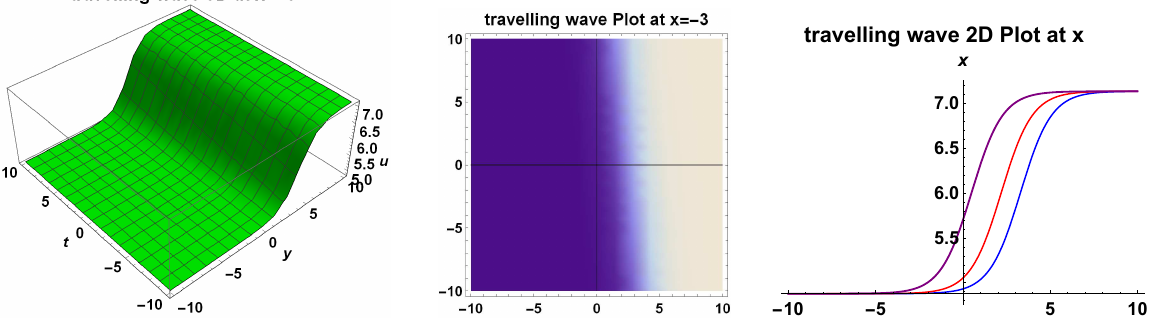
Figure 26. Tavelling wave profile depiction of nontrivial solution (113) at x = − 3.